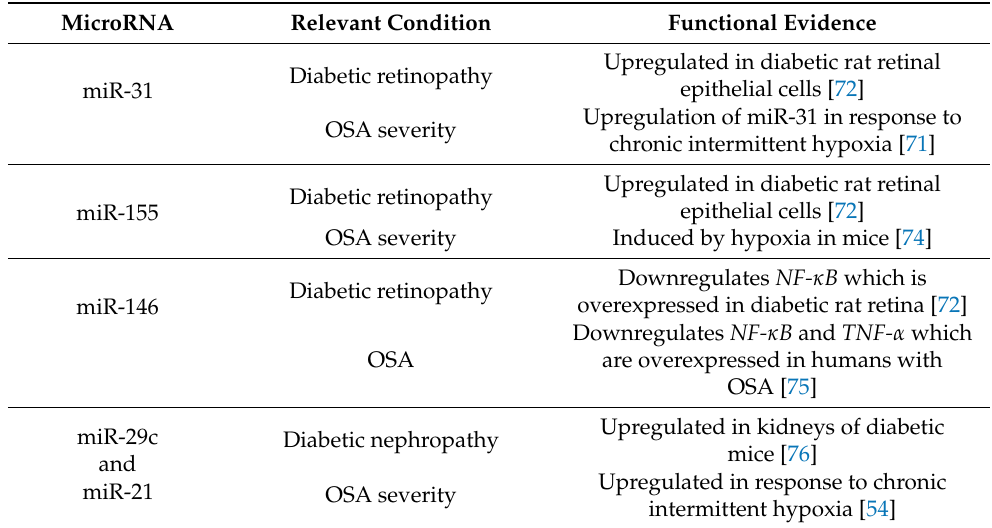
Table 2. Evidence of microRNAs connecting OSA and